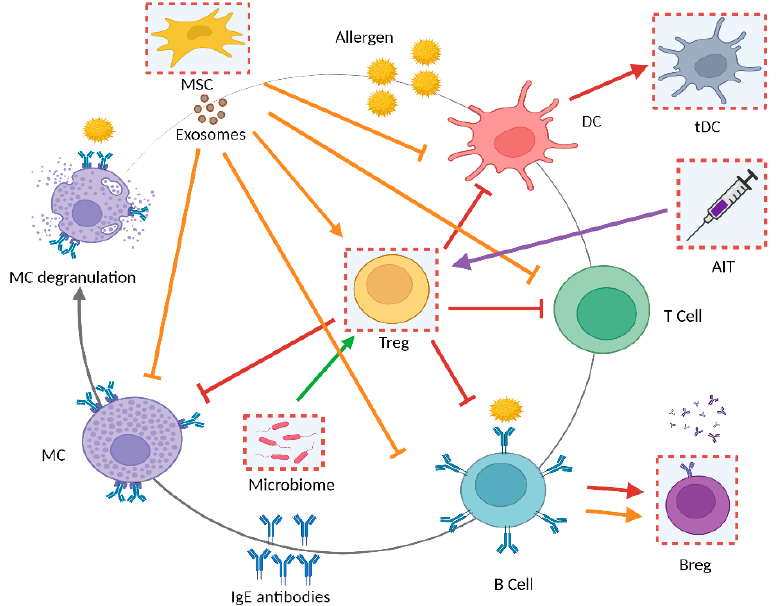
Figure 2. Schematic representation of the allergy players and the key points where the cell therapy and bio ‐ or nano ‐ material ‐ based approaches described in this review could be used to achieve tolerance in allergy treatments. AIT, allergen-specific immunotherapy; B Cell, B lymphocytes; Breg, regulatory B lymphocytes; DCs, dendritic cells; IgE, allergen-specific immunoglobulin E; MCs, mast cells; MSC, mesenchymal stromal cells; tDCs, tolerogenic dendritic cells; Treg, regulatory T cells. Created with BioRender.com (7 December 2021).